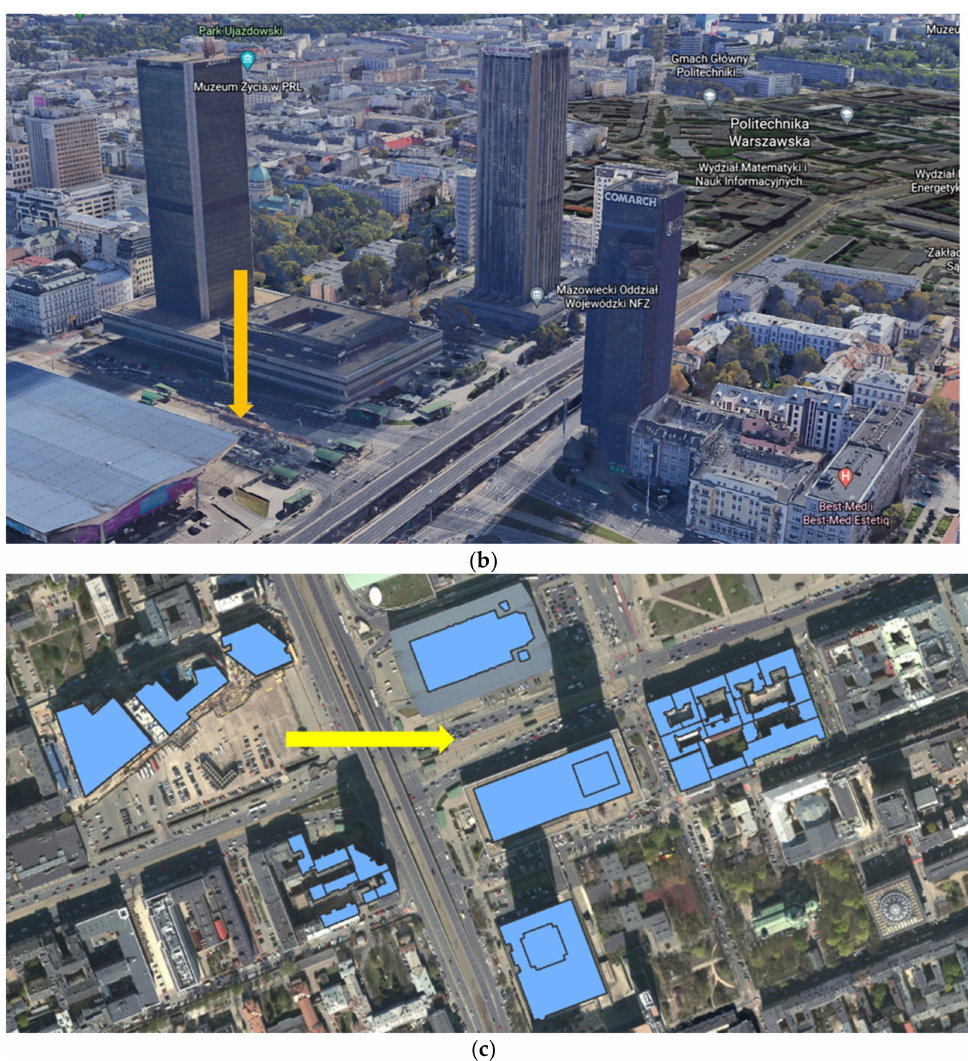
Figure 5. The location of the Dworzec Centralny 08 tram stop. ( a ) Visualization of the location of the Dworzec Centralny 08 tram stop (source: Google Maps, 2021). ( b ) The surroundings of the Dworzec Centralny 08 tram stop, view from the northwest (source: Google Earth 2021). ( c ) Visualization of the outlines of buildings (blue) in the vicinity of the Dworzec Centralny 08 tram stop (data sources: BDOT10k and orthophotomap (WMS) provided by PZGiK).